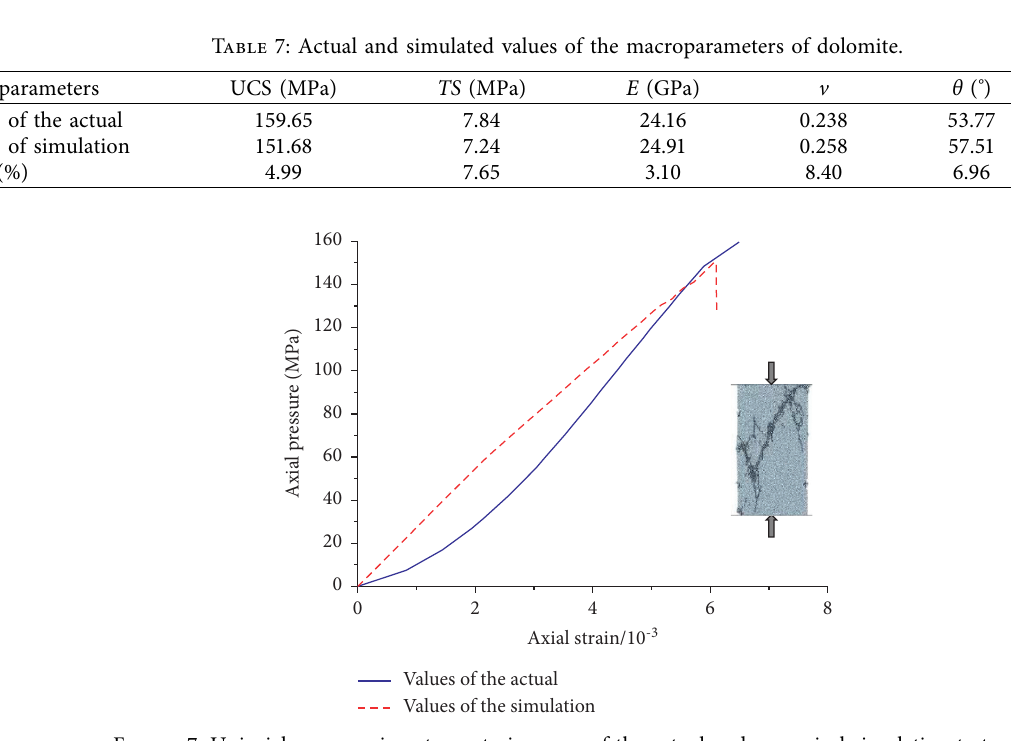
Figure 7: Uniaxial compression stress-strain curve of the actual and numerical simulation